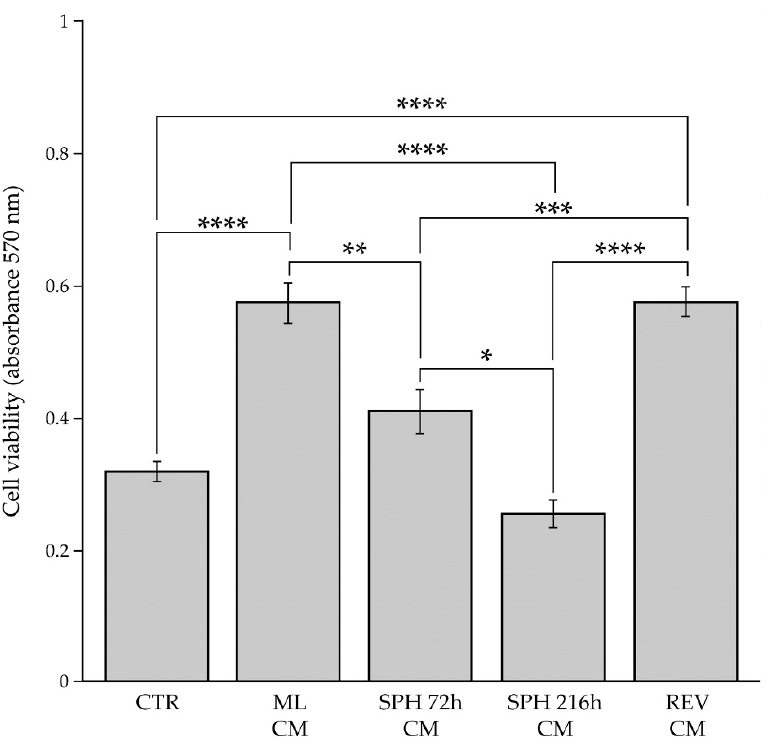
Figure 7. Influence of tumor stromal microenvironment on the viability of BC cells. MCF-7 cells were grown for 48 h with the conditioned media derived from BCAF monolayers (ML CM), spheroids at 72 h (SPH 72 h CM), spheroids at 216 h (SPH 216 h CM) or reverted BCAFs (REV CM). Control is represented by MCF-7 cells incubated with unconditioned medium (CTR). The cell viability was evaluated by MTT assay. Data are means of three independent experiments ± S.E. * p < 0.005, ** p < 0.001, *** p < 0.0005, **** p <